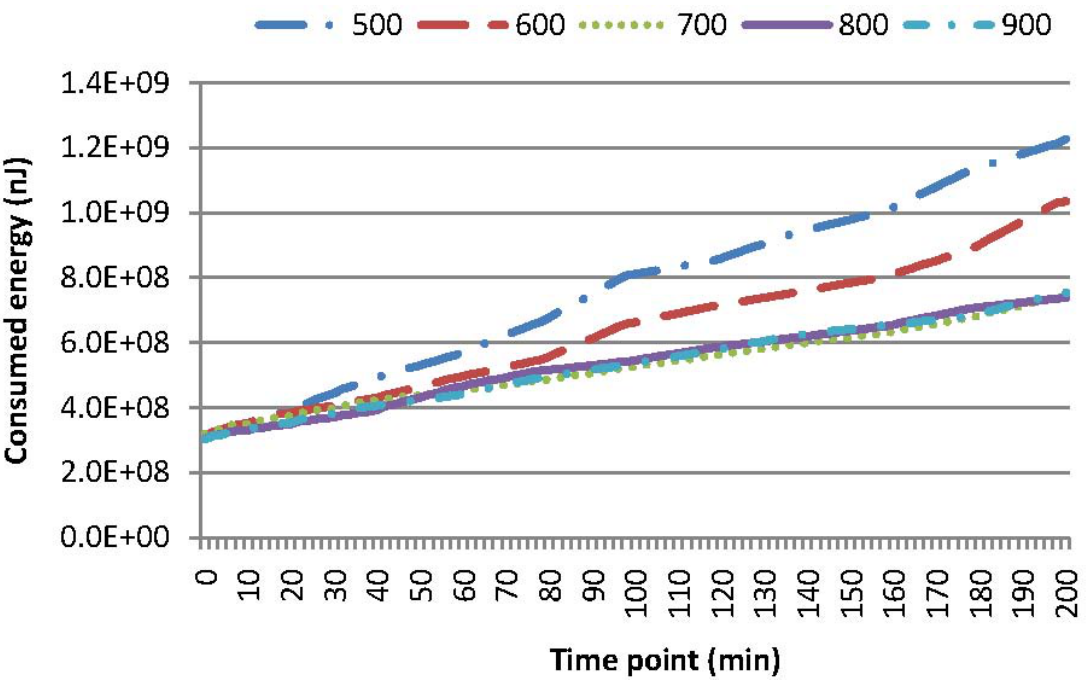
Figure 5. Comparison of the accumulated energy consumption for MAQWR, where the cache size of the SN is set to 500 , 600 , 700 , 800 and 900 , respectively. The gradient of the curves represents the ratio of energy consumption for answering the query. This figure shows that when the cache size of the SN is large enough to cache all sensory data requested by the query, the energy consumption is relatively small and steady. Otherwise, the energy consumption is much more and increases significantly. For instance, in comparison with the case when the cache size is set to 800, 66% (or 40%) more energy is consumed for the case when the cache size is set to 500 (or